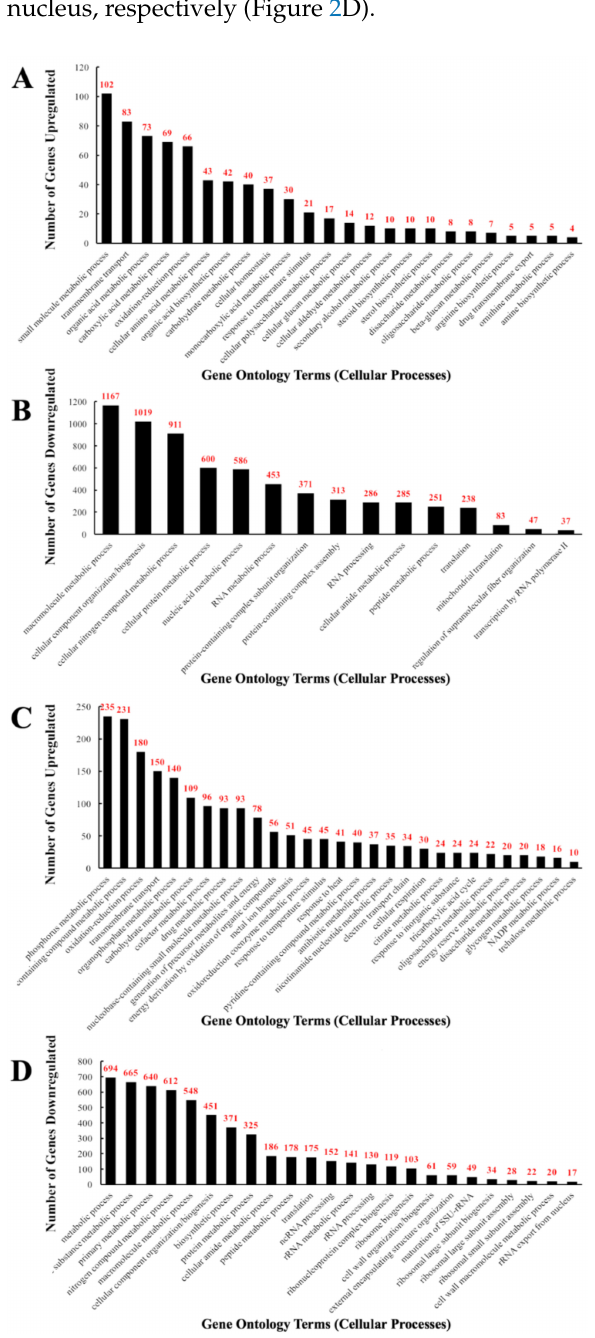
Figure 2. Bar graphs of the number of differentially expressed genes implicated in GO-terms that represent one specific cellular function altered when exposed to QDs in yeast. The number of dif- ferentially expressed genes (DEGs) on each bar represents the number of an altered gene for the corresponding GO-term with p -values of 0.05 or below. ( A ) The total number of upregulated DEGs implicated in the listed GO-terms in CdSe/ZnS-treated cells. ( B ) The total number of downregulated DEGs implicated in the listed GO-terms in CdSe/ZnS-treated cells. ( C ) The total number of upreg- ulated DEGs implicated in the listed GO-terms in InP/ZnS-treated cells. ( D ) The total number of downregulated DEGs implicated in the listed GO-terms in InP/ZnS-treated